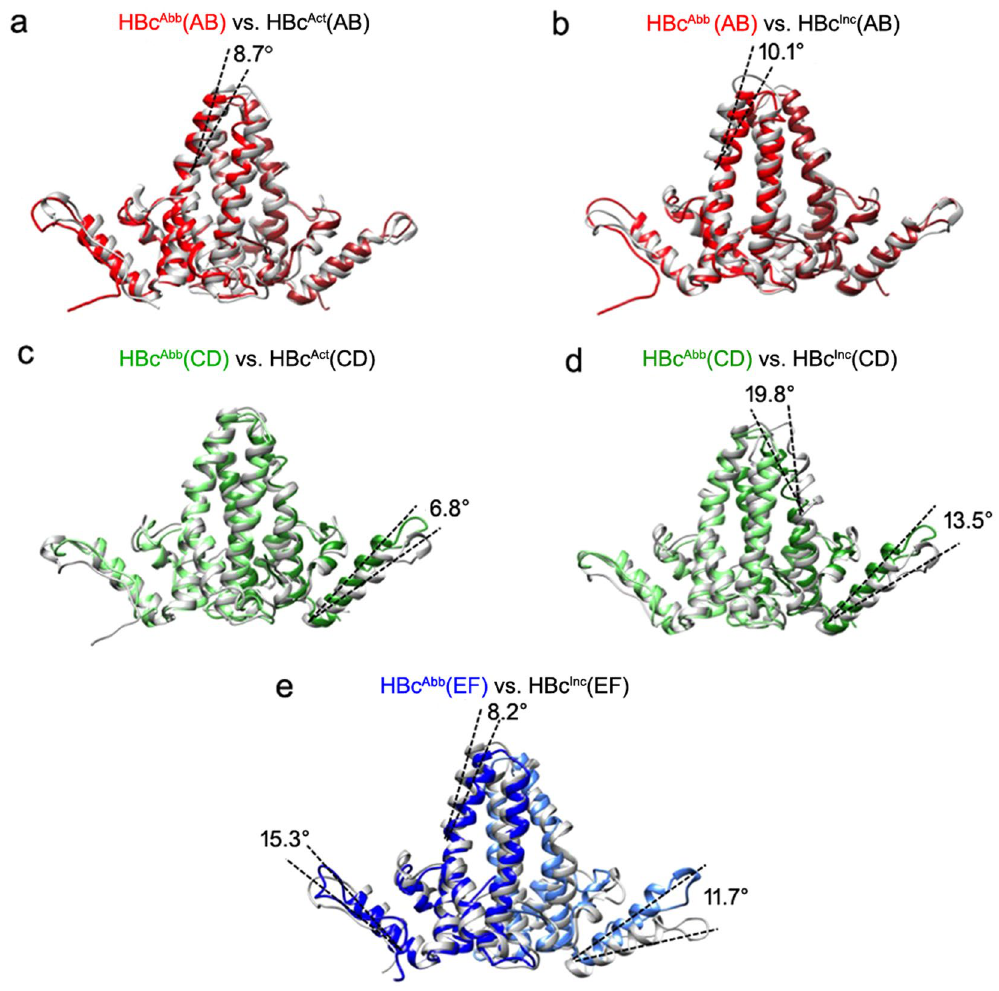
Figure 4. Structural comparison of HBc dimers in tube, capsid and sheet-like ensemble. ( a , b ) Overlays of the HBc AB dimer in tube with that in capsid (PDB ID 1QGT) and sheet-like ensemble (PDB ID 3KXS). ( c , d ) Overlays of HBc CD dimer in tube with that in capsid (PDB ID 1QGT) and sheet-like ensemble (PDB ID 3KXS). ( e ) Overlay of HBc EF dimer in tube with that in sheet-like ensemble (PDB ID 3KXS). The significant conformational differences are marked with the helix shift angles